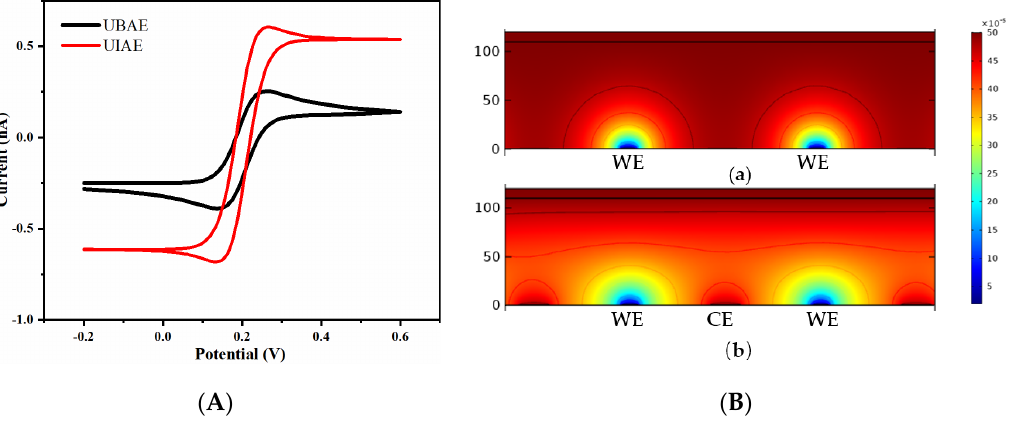
Figure 4. Simulation comparison results of UBAE and UIAE with spacing-to-width ratio of 13: ( A ) cyclic voltammogram; ( B ) concentration distribution diagram: ( a ), UBAE; ( b ), UIAE.